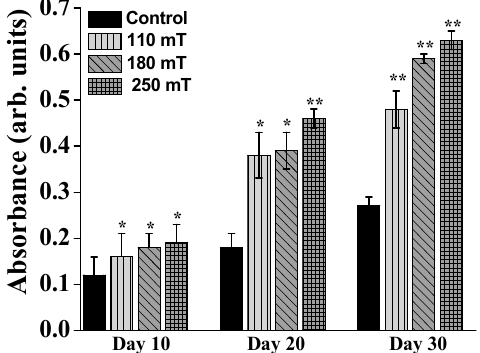
Figure 9. Absorbance measurements for Alizarin Red marking of the mineral deposits in MG-63 osteoblast-like cells growing on ellipsoidal multilayered 3D structures having the layers spatially separated by cylindrical pillars, as a function of the applied static magnetic fields. Results for unstimulated samples (controls) are shown for comparison. Each bar represents the mean ± STD. Statistical significance was determined by Student’s t -test (* p ≤ 0.05, ** p ≤ 0.001).